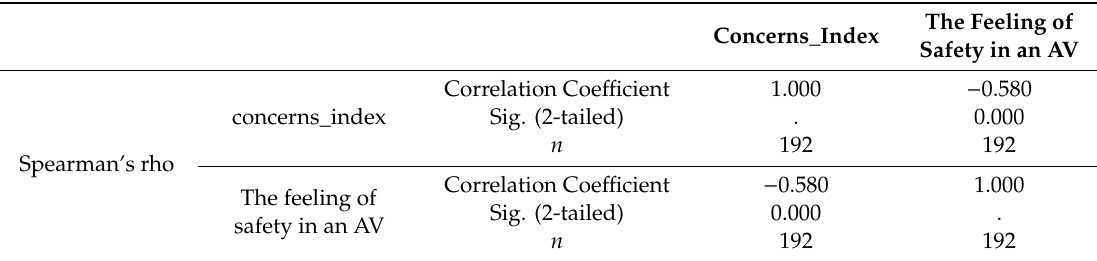
Table 13. Correlations concerns index and feeling of safety in an AV.